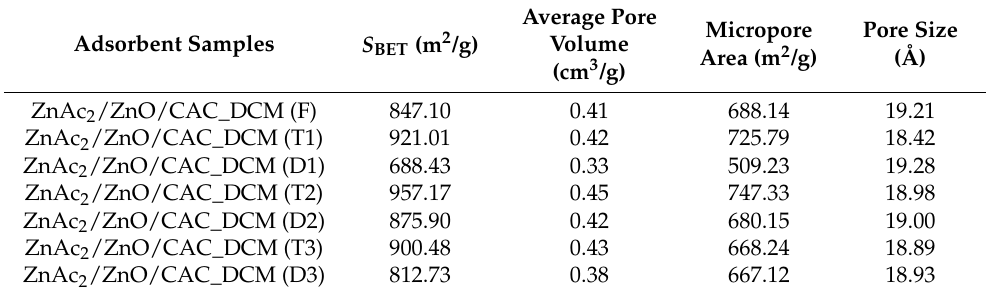
Table 5. Porous properties of ZnAc 2 /ZnO/CAC_DCM in three H 2 S adsorption–desorption